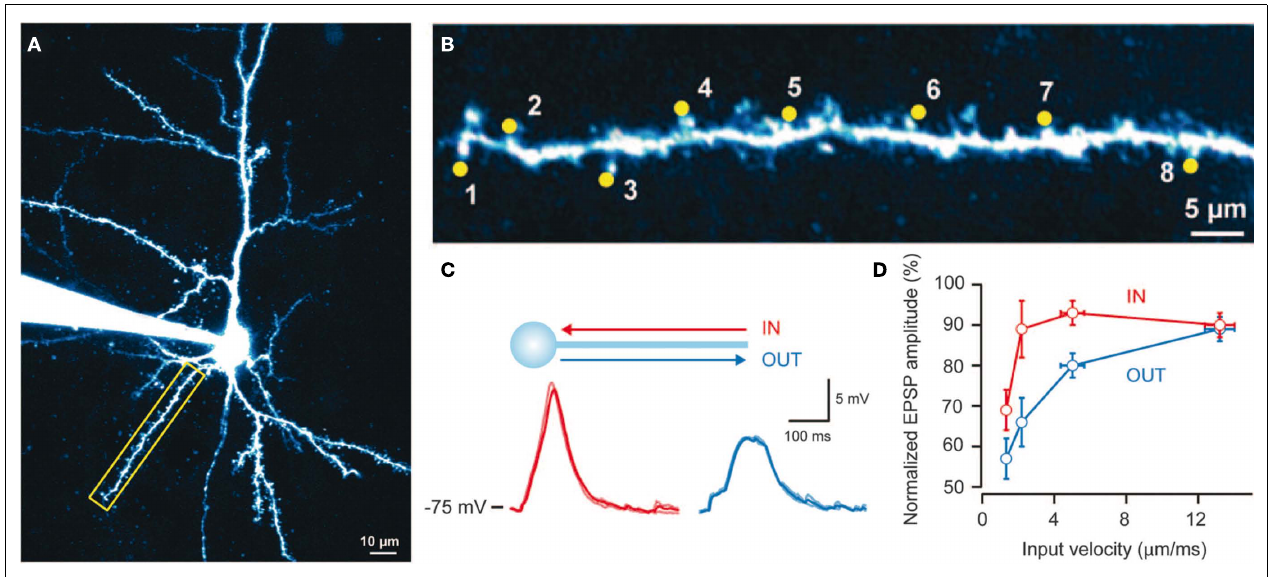
(C) Somatic responses to IN (red) and OUT (blue) directions at 2.3mm/ms. (D) Relationship between peak voltage and input velocity (values normalized to the maximum response in the IN direction for each cell, n = 15). Error bars indicate SEM. Reproduced from Branco et al. (2010) with